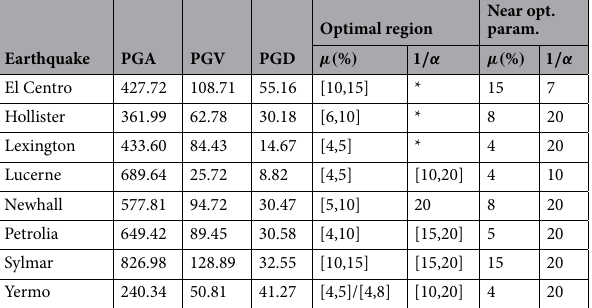
Table 2. Near optimal design seismic isolation parameters for the CDMG